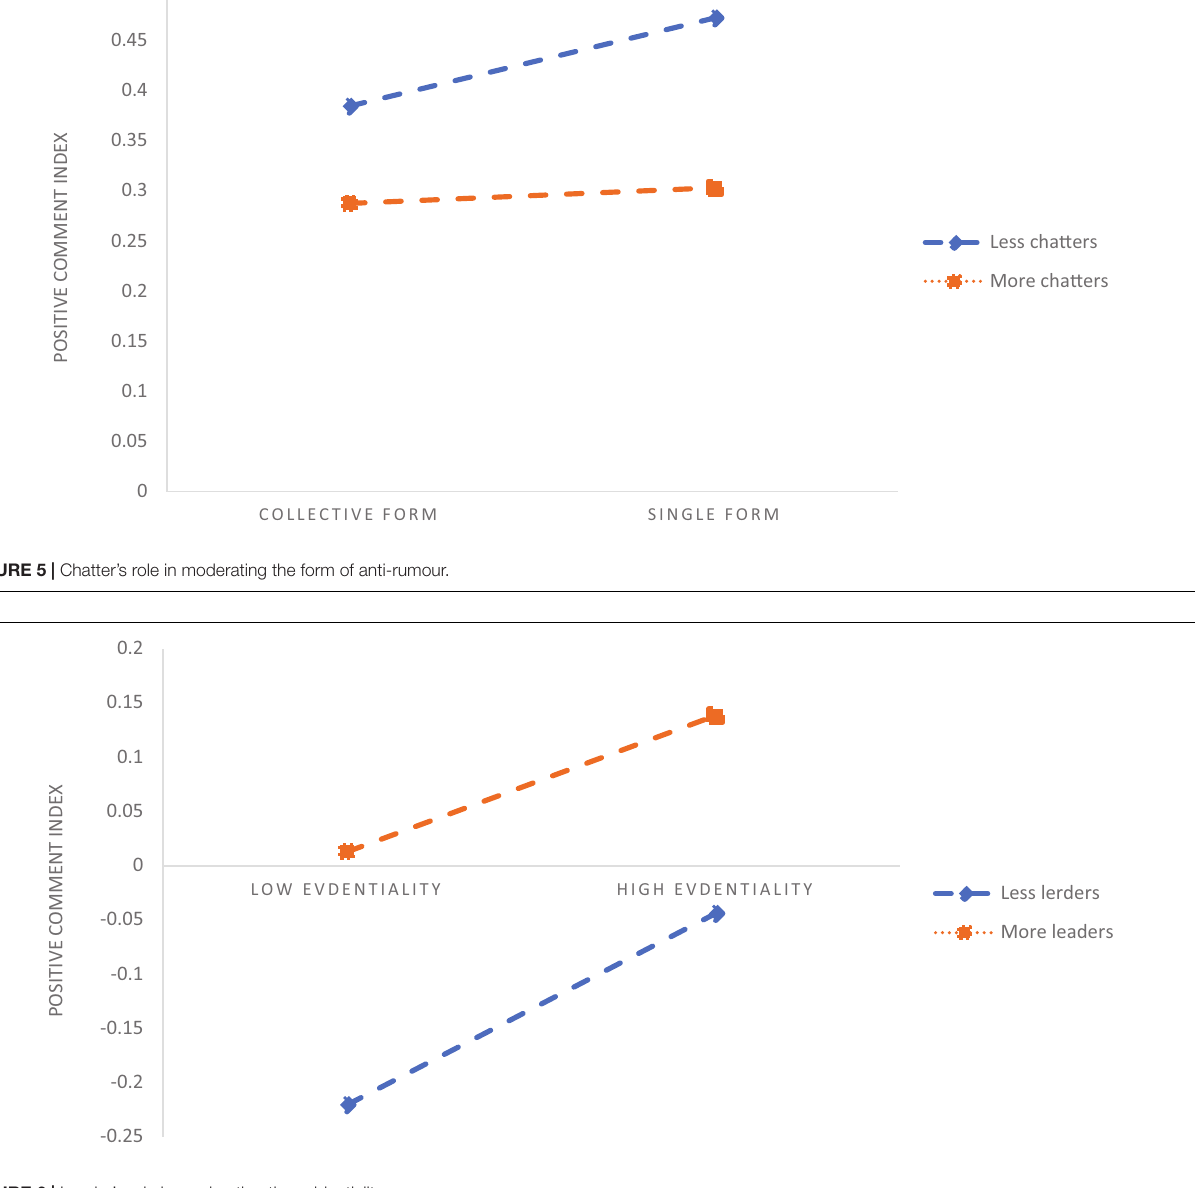
FIGURE 6 | Leader’s role in moderating the